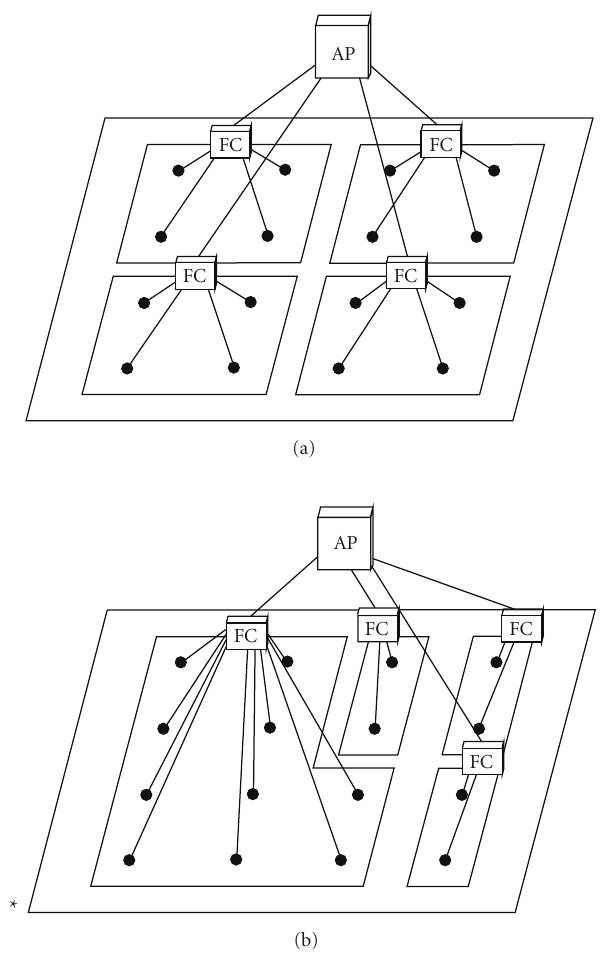
Figure 1: An example of clustered sensor networks with N = 16 sensors: (a) uniform clustering and (b) nonuniform